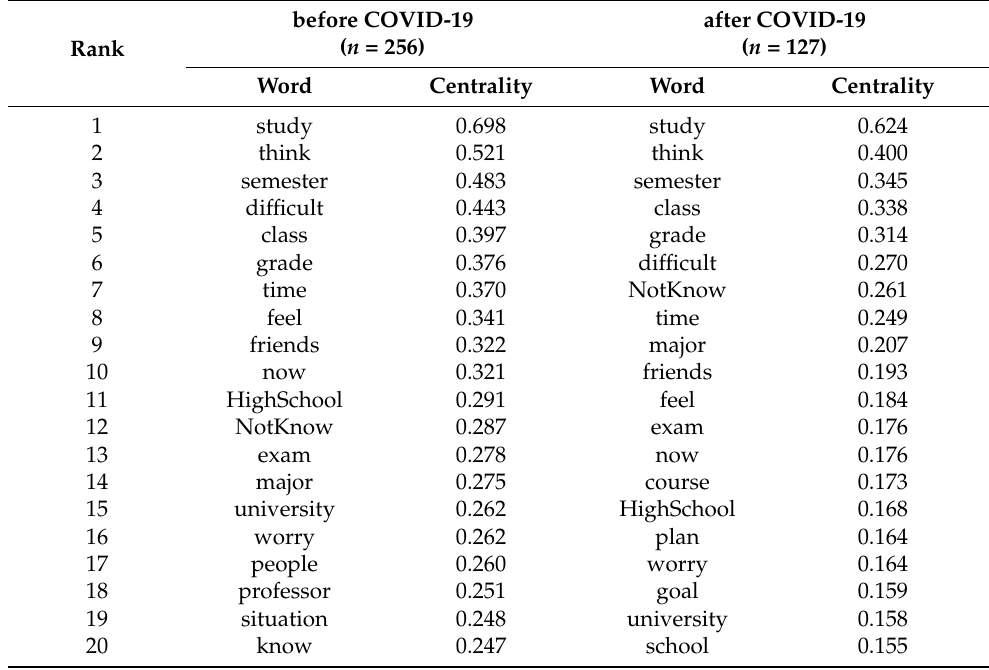
Table 4. Centrality of the top-ranked words before and after COVID-19.